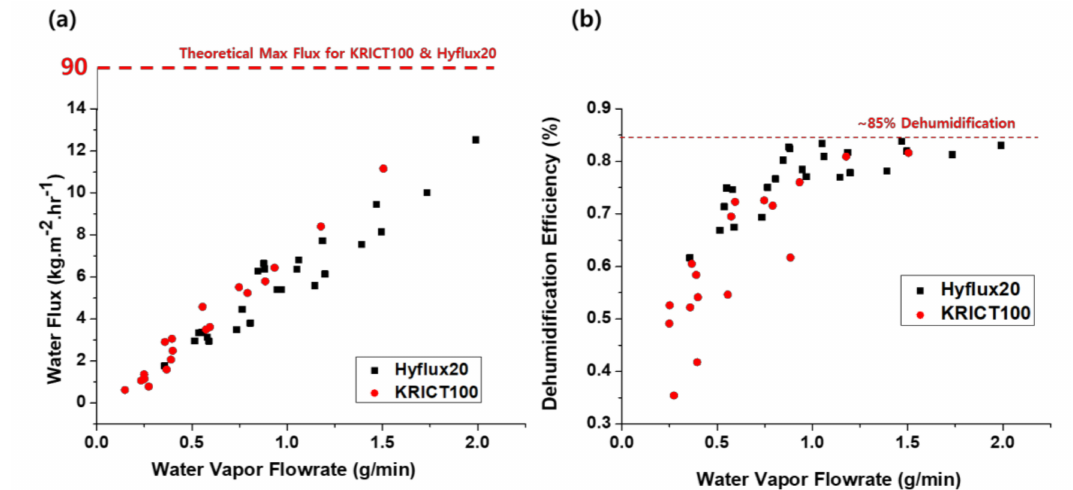
Figure 6. ( a ) Water flux plotted against the inlet water vapor flow rate, showing a linear relationship. ( b ) Dehumidification efficiency, performance comparison, and dehumidification efficiency (reprinted with permission from